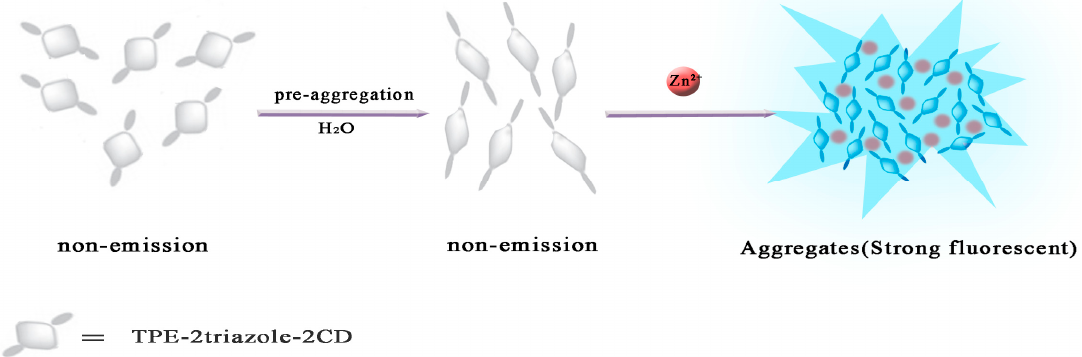
Figure 3. ( a ) Fluorescence emission spectra change of TPE-2triazole-2CD exposed to Zn 2+ of various concentrations: 0, 0.5, 1, 2.5, 5, 7.5, 10, 12.5, 15, 17.5, 20.0, 25, 37.5, 50 μ M from bottom to top (DMSO/H 2 O = 2/3, v / v ); ( b ) Fluorescence titration curve of TPE-2triazole-2CD with Zn 2+ in DMSO-H 2 O (2/3, v / v ) solution.